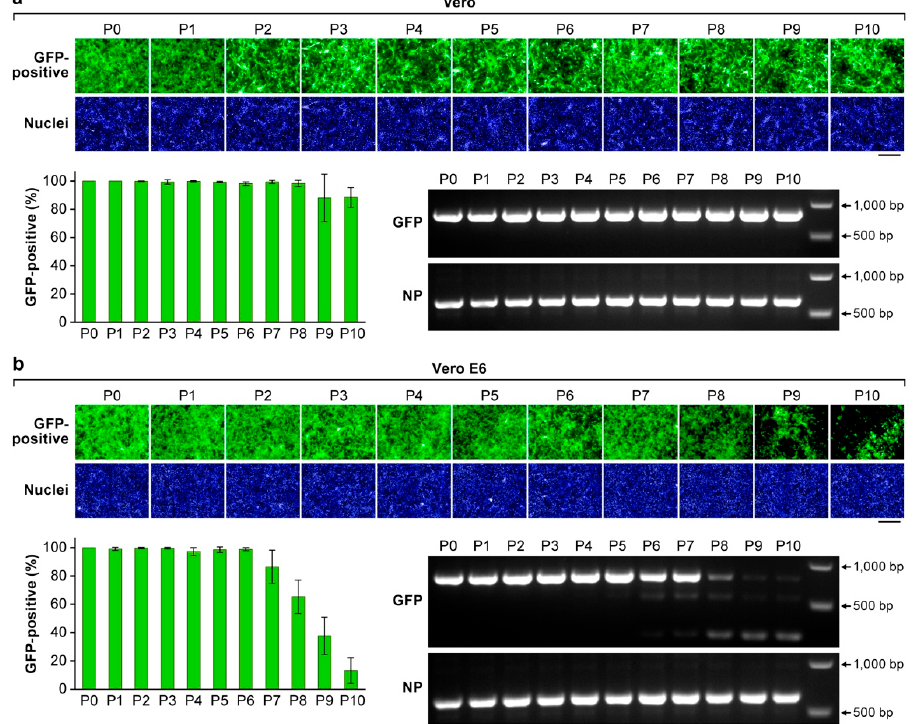
Figure 3. Stability of the GFP reporter gene expressed by rLASV-GFP. Cells were exposed to rLASV- GFP (MOI = 0.01). At 72 h PI, TCS were collected (passage 1, P1), and virus titers were determined by plaque assay. Fresh Vero ( a ) or Vero-E6 cells ( b ) were exposed to with TCS from P1 (MOI = 0.01). This process was serially repeated throughout P10. GFP expression (green) was measured by high-content